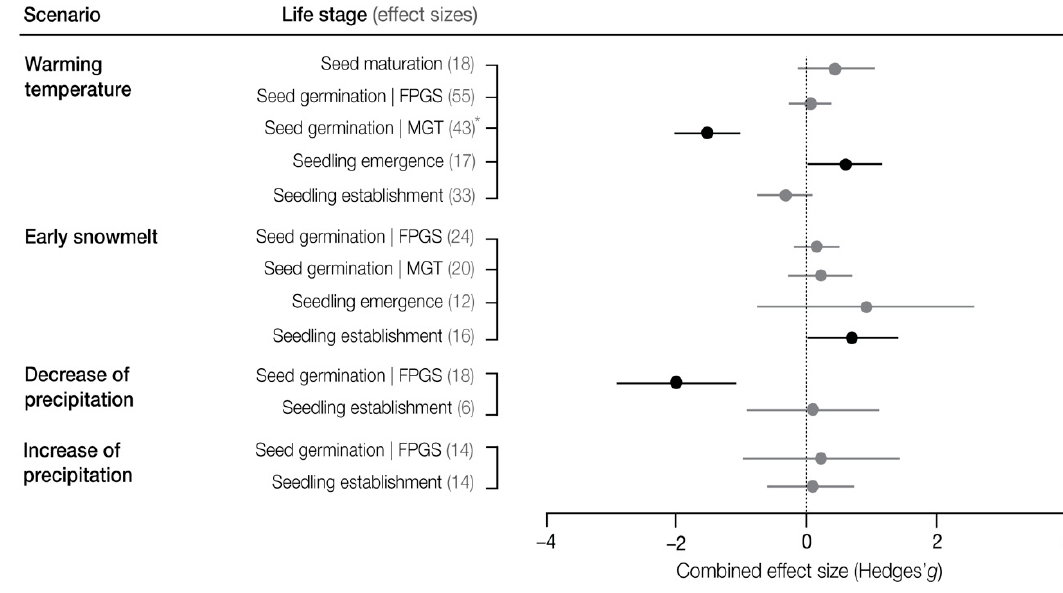
Figure 5. Combined effect sizes (Hedges’g and ±95% confidence intervals) of the impacts of climate change scenarios on early life-history stages of high altitude and high latitude plants. Black dots indicate a statistically significant meta-analytic effect. Gray dots indicate that the combined effect is not significantly different from zero. * Observe that the combined effect size for mean germination time on the negative side of zero, was interpreted as a positive effect in the results and discussion. FPGS: final proportion of germinated seeds, MGT: mean germination time.